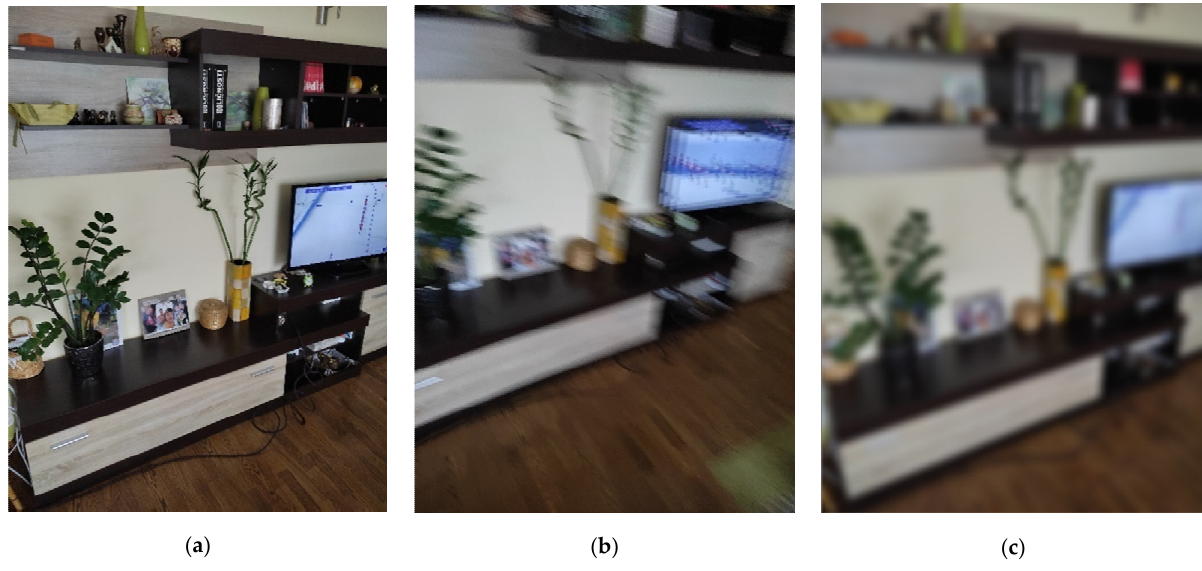
Figure 1. Illustration of different blur types: ( a ) non-blur; ( b ) motion blur; ( c ) out-of-focus blur. In [12], it is shown that the blurring process can be defined as B = A ⊗ k + n , where B represents the blurred image, A is the clear image, ⊗ denotes the convolution operator, k is the blur kernel, and n corresponds to the noise. Blur kernels are strictly correlated with the blur type, so, for instance, a mathematical model of motion blur in the form of a line can be represented by the following